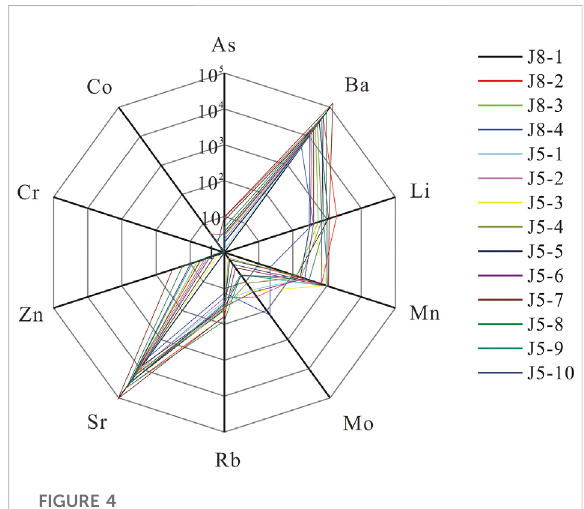
FIGURE 4 Radar map of trace elements concentration of coalbed- produced water in the Linfen mining